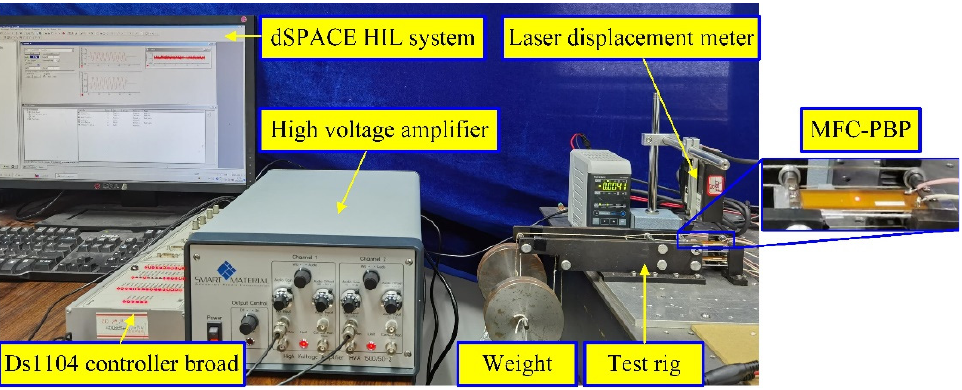
Figure 3. Test platform for MFC-PBP.